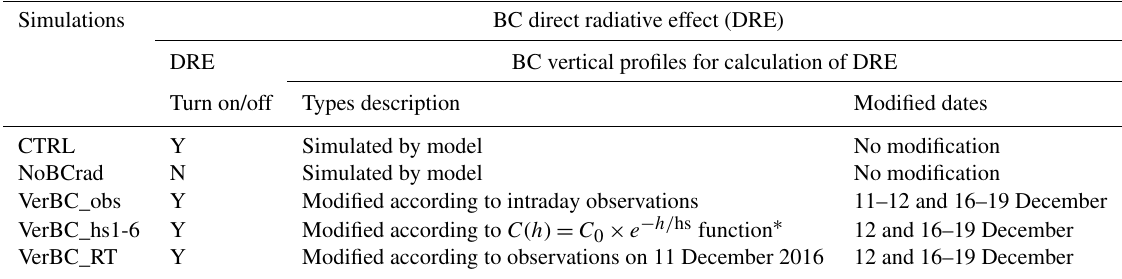
Table 2. Numerical experiments. Y indicates “on”, and N indicates “off”. Simulations BC direct radiative effect (DRE) DRE BC vertical profiles for calculation of DRE Turn on/off Types description Simulated by